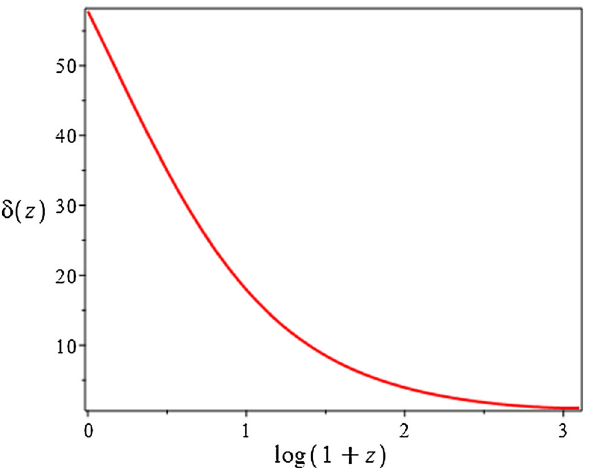
Fig. 1 The δ( z ) versus redshift z for Eq. (87) for dust dominated Uni- verse for GR limit